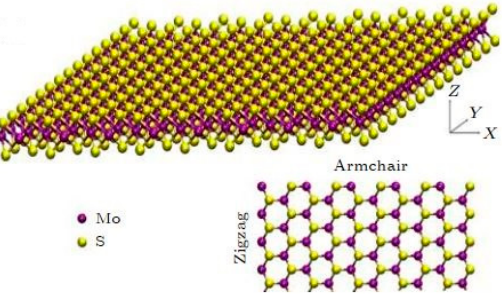
Figure 9. Molybdenum sulfide [151]. Reprinted with permission from ref. [10]. AIP Publishing and Copyright Clearance Center. Table 3. Experimental results of thermal conductivity of single-/few-layer MoS 2 in different kinds of